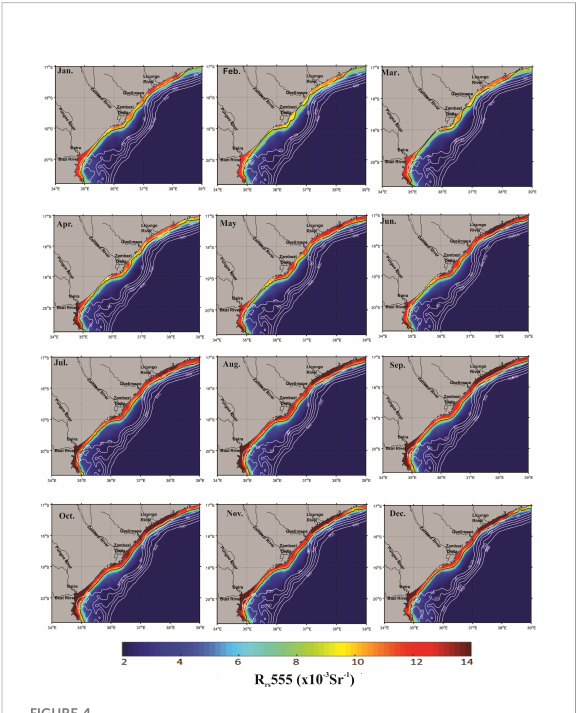
FIGURE 4 Climatology of seasonal variation of R rs 555 over the Sofala Bank for the period of 2003 – 2016. The black line represents the sediment plume edge (0.01 Sr − 1 ), estimated from linear